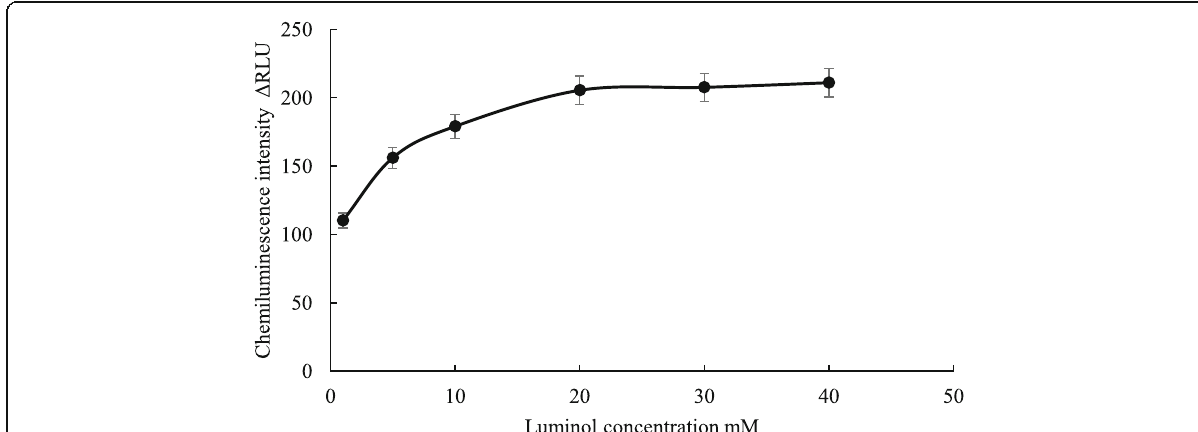
Fig. 5 A calibration curve showing the influence of luminol concentrations while keeping the concentration of hydrogen peroxide constant (10 mM) on the CL emission